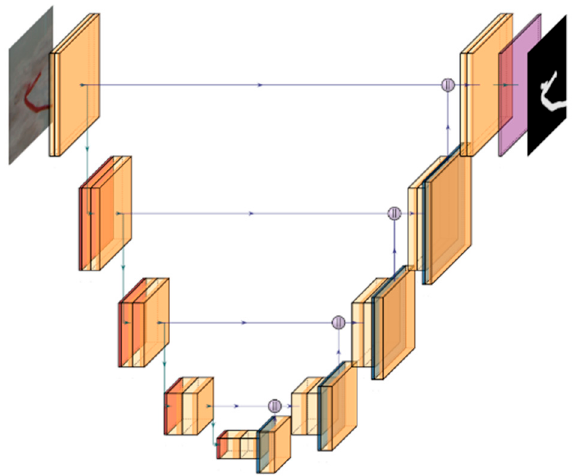
Figure 1. The structure of U-Net.